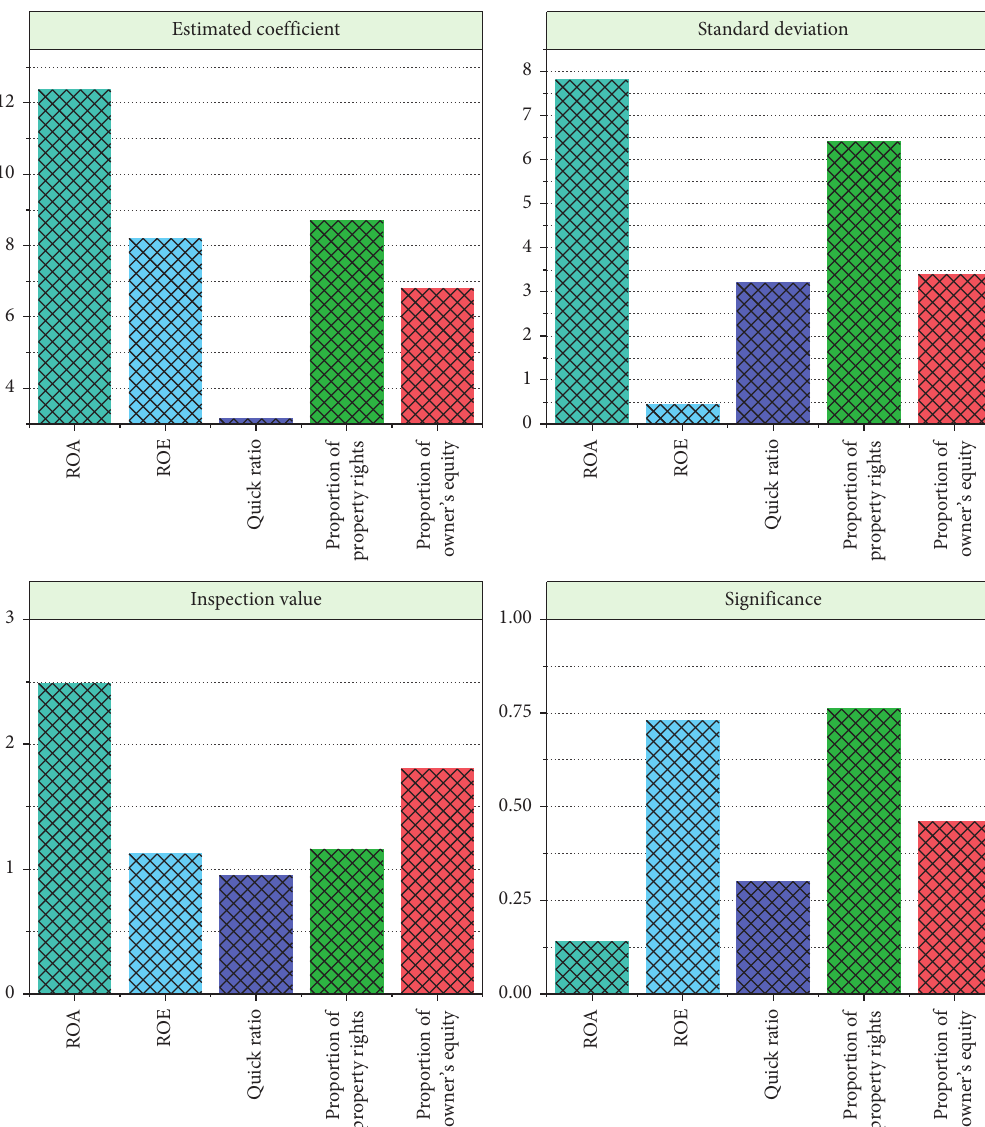
Figure 6: Regression analysis on the model of investigation after the